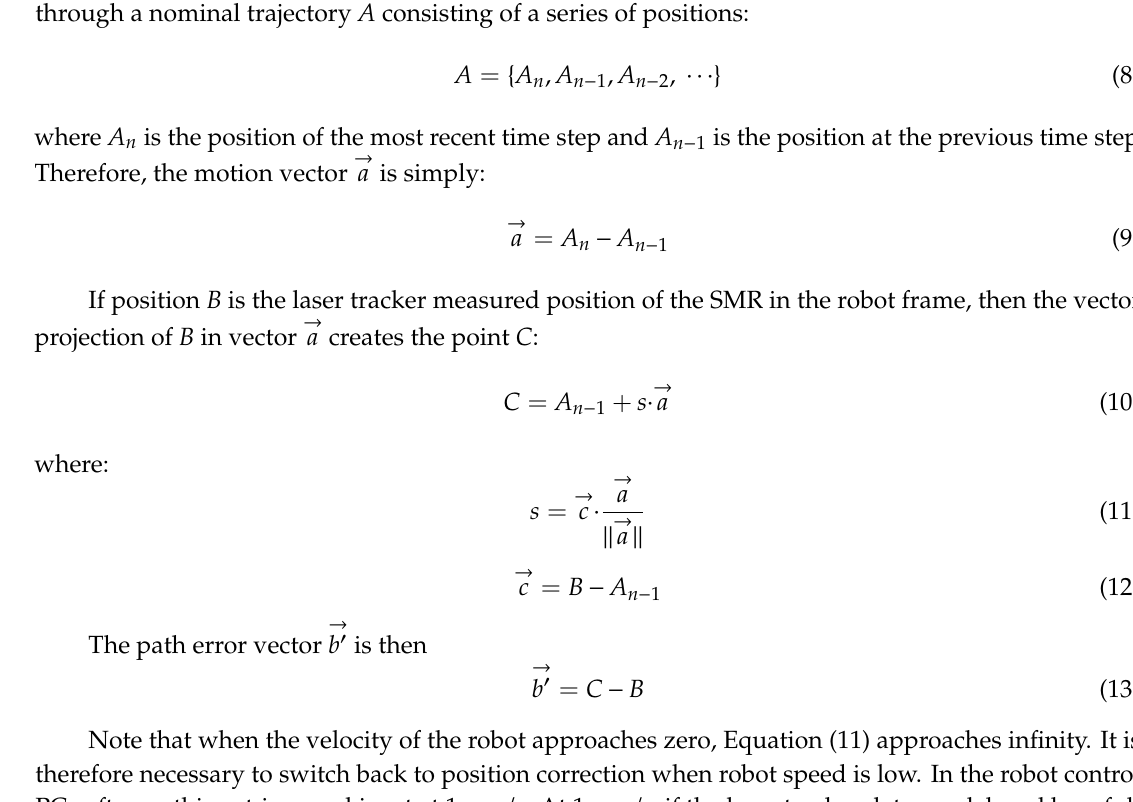
Figure 10. Position error vector (b (cid:1318) ) vs. path error vector ((b ′ ) (cid:1318) ).